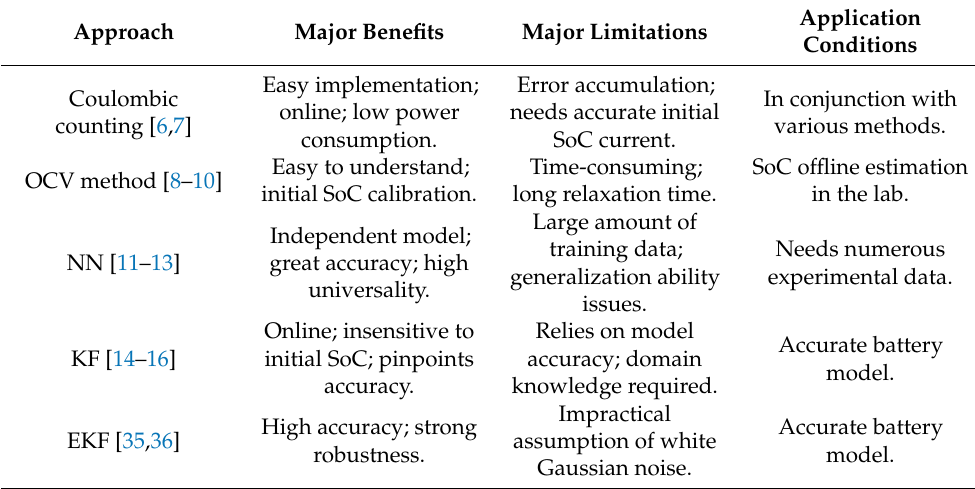
Table 1. Summary of battery SoC estimation methods.